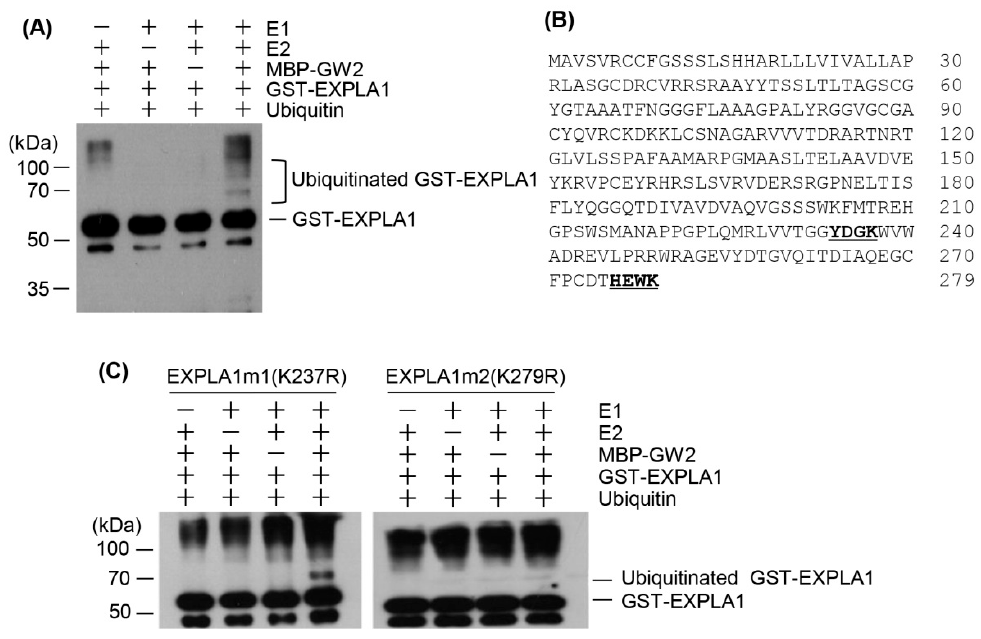
Figure 4. EXPLA1 is ubiquitinated by GW2 in vitro. ( A ) The ubiquitination reactions were performed in the presence or absence of rabbit E1, UbcH5b (E2), MBP–GW2 (E3), His 6 -ubiquitin, and GST–EXPLA1. Ubiquitinated EXPLA1 was detected by western blotting using an anti-GST antibody; ( B ) Deduced amino acid sequences of the EXPLA1 protein. Two putative ubiquitination sites are underlined in bold; ( C ) In vitro identification of the ubiquitination site on EXPLA1. The ubiquitination reaction mixture contained E1, E2, MBP–GW2 (E3), and His 6 -ubiquitin without ( − ) or with (+) a substrate protein. The mutant proteins, EXPLA1m1 and EXPLA1m2, have amino acid substitutions at residues that are predicted to be ubiquitin conjugation sites in EXPLA1, as indicated. After the reaction, ubiquitinated EXPLA1 protein was detected by western blotting with an anti-GST antibody.